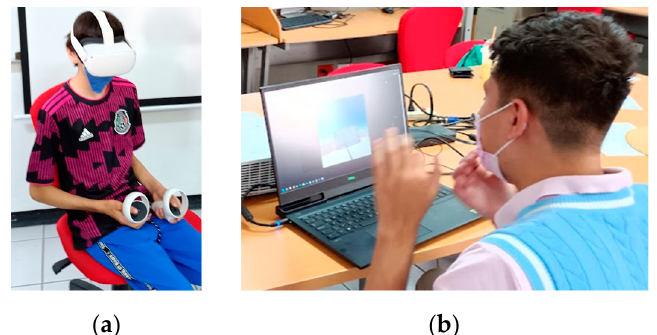
Figure 11. ( a ) Child with ASD interacting with the application through OCULUS devices. ( b ) Monitoring of the activity performed in the virtual environment by the development team.